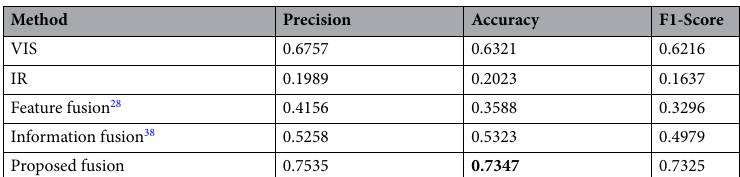
Table 4. Comparison of different sensor fusion approaches. The VGG 16 model is applied in all experiments to ensure comparability. The highest accuracy value is in [bold].